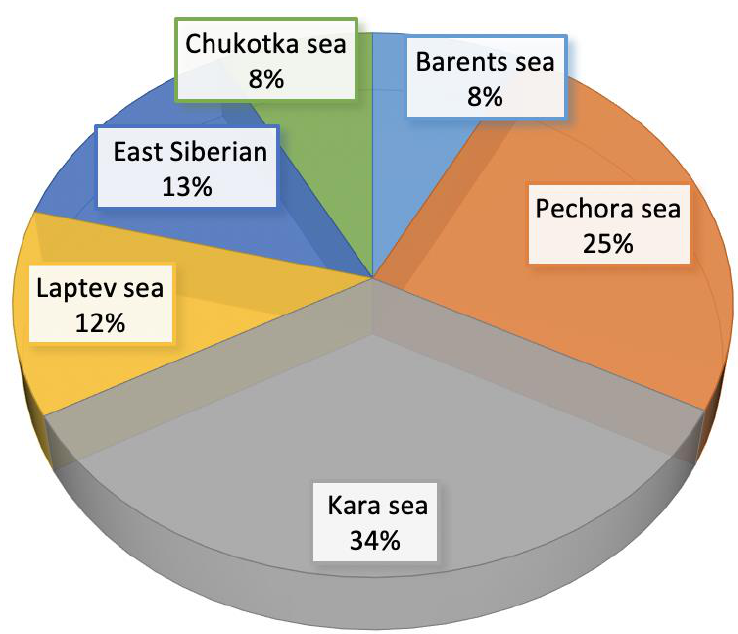
Figure 15. Distribution of oil resources in the Arctic seas of Russia.